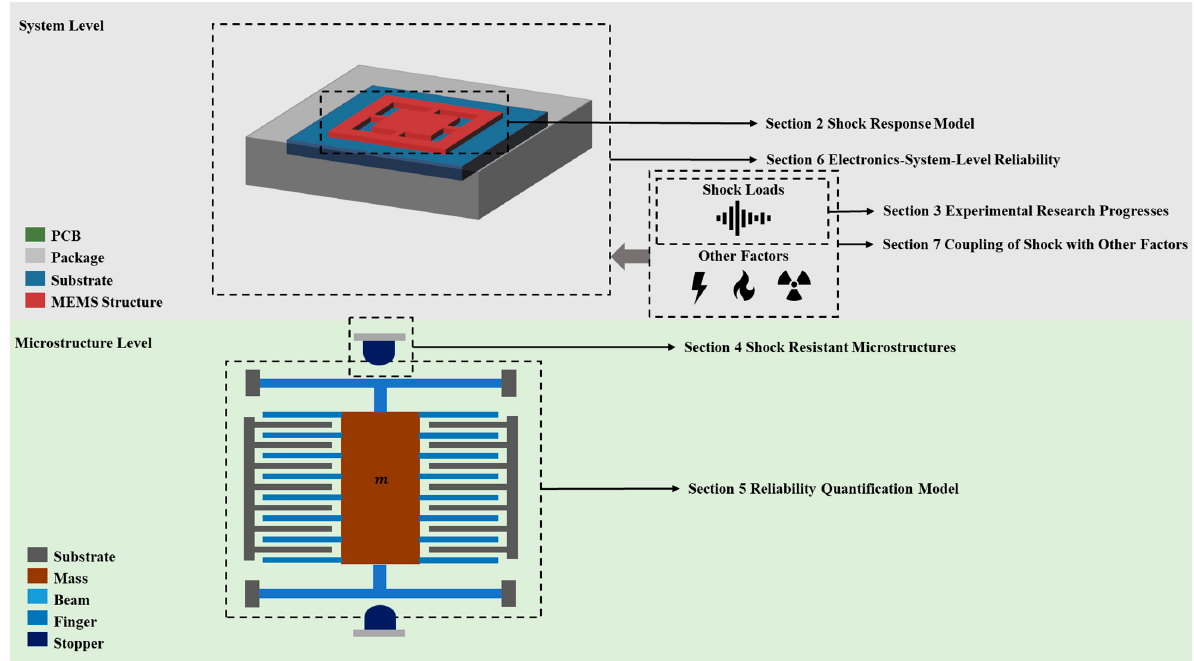
Figure 1. Contents of this paper.